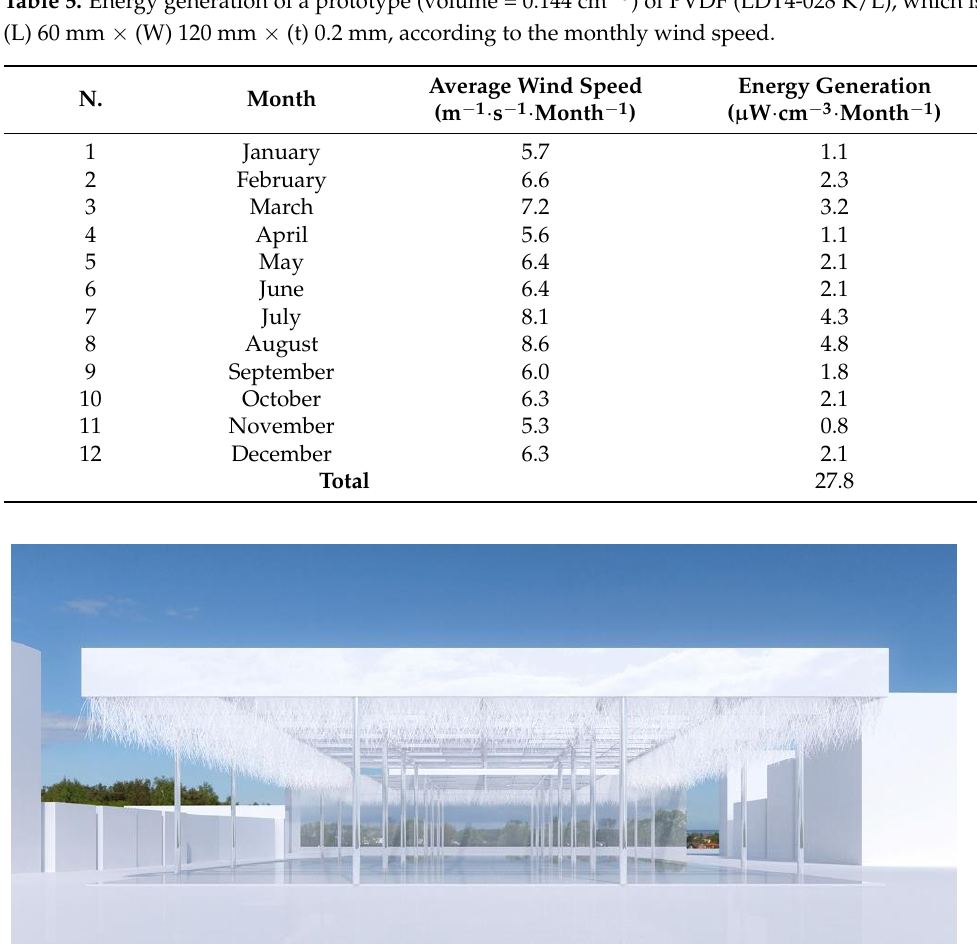
Figure 12. The expected image of piezoelectric materials to be installed under the roof of the pergola at Lanzarote Dynamic Square.